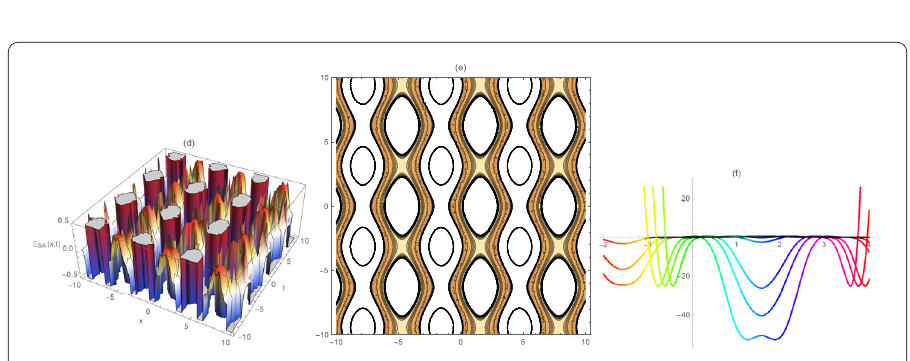
Figure 5 Semi-analytical wave solution of the Cahn–Allen equation by using Eq. (37) in three- ( d ), two- ( f ) dimensional, and contour ( e ) plots when x ∈ [–10,10], t ∈ [–10,10]